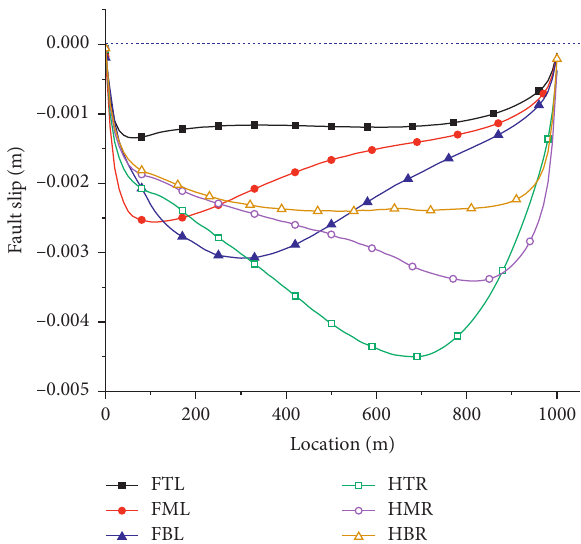
Figure 14: Fault slip along the fault plane when the fracturing region was FTL, TBL, FML, HTR, HMR, or